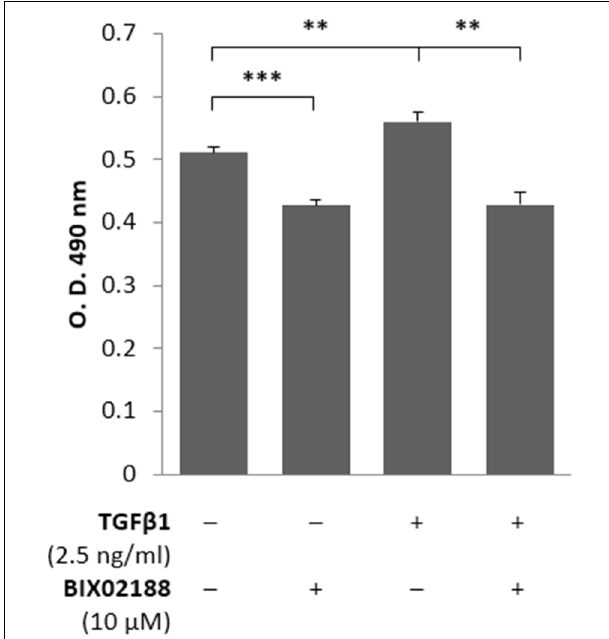
FIGURE 2 | Regulation of podocyte proliferation via Erk5. Colorimetric cell proliferation assay investigating proliferation of podocytes pre- incubated for 60 min with the Mek5 inhibitor BIX02188 (10 μ M) followed by co-incubation withTGF β 1 (2.5 ng/ml) for 48 h.TGF β 1 induced podocyte proliferation which was prevented with BIX02188 co-treatment. ** P < 0.01, *** P < 0.001; paired t -test, n = 6. (10 μ M) followed by co-incubation with TGF β 1 (2.5 ng/ml) for